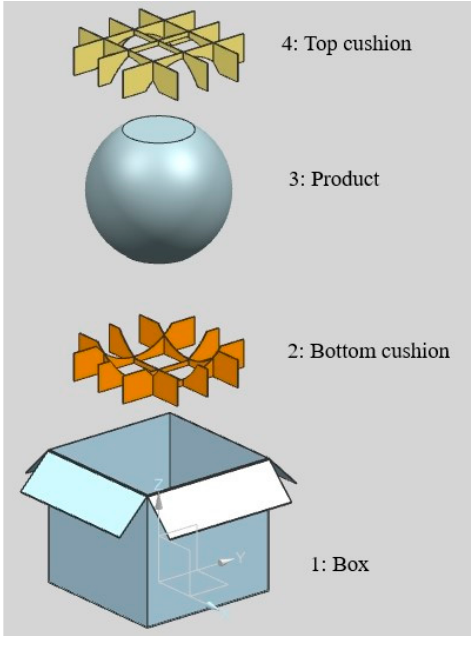
Appl. Sci. 2020 , 10 , x FOR PEER Figure 3. 3D Computer Aided Design (CAD) packaging design. Figure 3. 3D Computer Aided Design (CAD) packaging design.